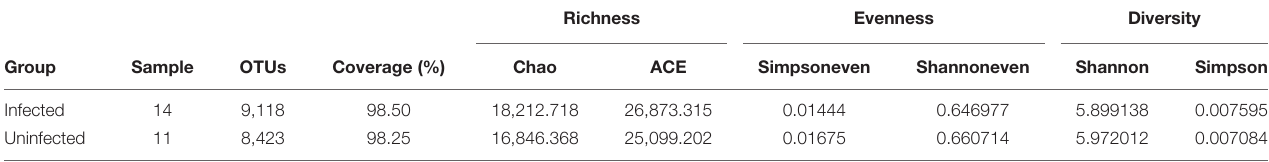
TABLE 2 | The diversity evaluation of the microbiomes of mice infected with cystic echinococcosis and uninfected